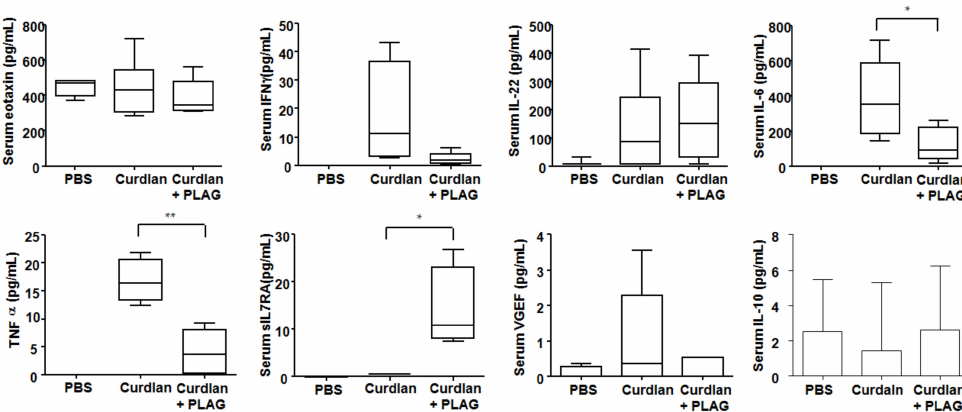
Figure 3. Serum cytokine levels at 20 weeks after a PBS or curdlan injection in SKG mice. The PLAG-treated curdlan-induced SKG mice had lower serum IL-6 and TNF- α levels compared with the curdlan-induced SKG mice without PLAG treatment. Interestingly, PLAG treatment upregulated sIL-7R α (an anti-fibrotic molecule) in the curdlan-induced SKG mice. The values represent the mean of three independent experiments ± SEM. * p < 0.05; ** p < 0.01. PLAG: acetylated